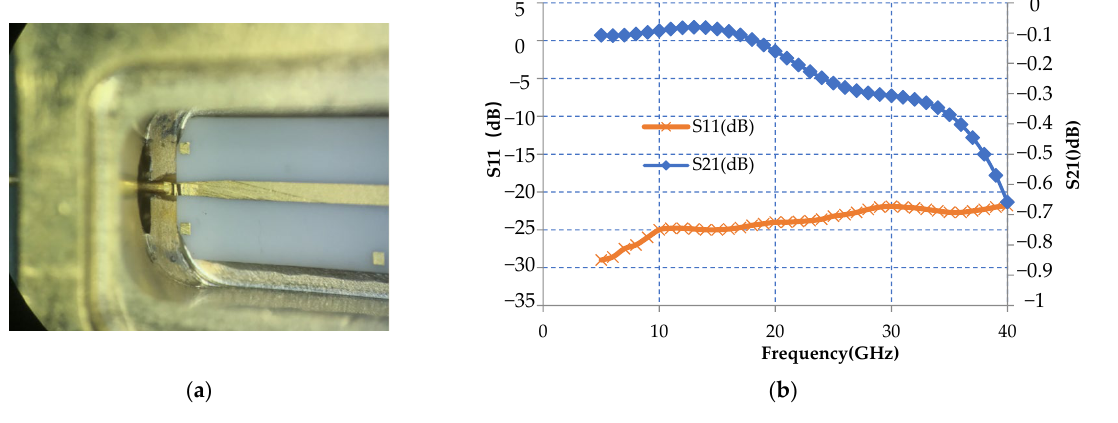
Figure 13. Actual photo and reflection loss of the novel horizontal interconnection. ( a ) Photo of the novel interconnection; ( b ) S-parameter of the novel interconnection.